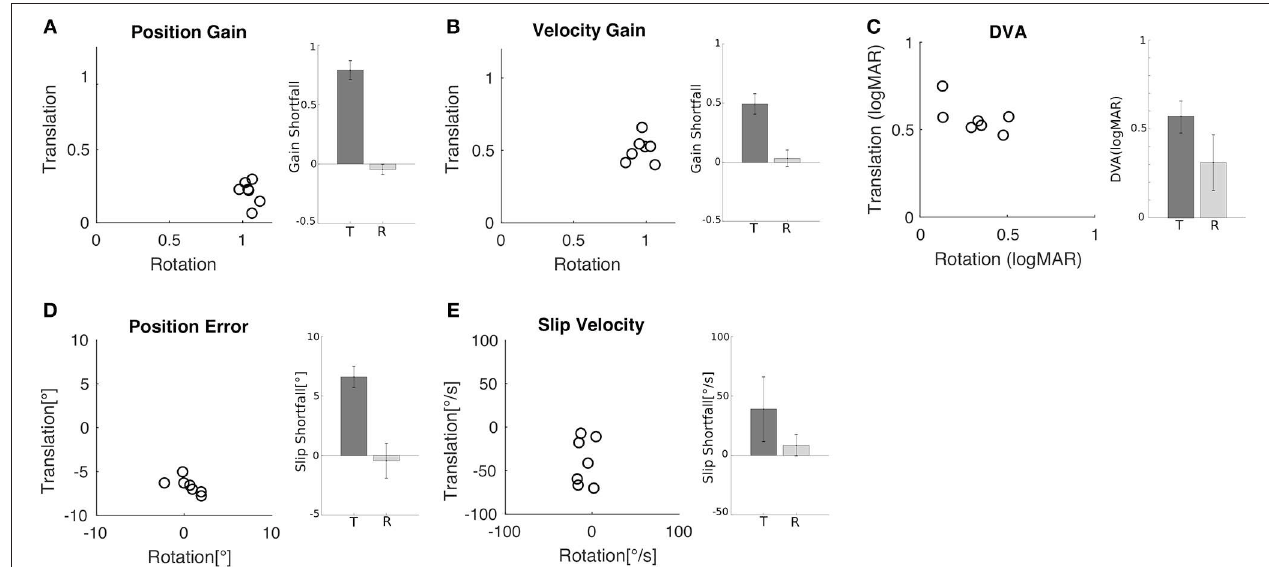
FIGURE 3 | Comparison of rotational and translational VOR gain, slip, and DVA. (A) Position error for translation vs. rotation for all subjects. Inset shows the mean ( ± SD) shortfall in gain relative to gain of one across subjects for translation (0.79 ± 0.08) and rotation ( − 0.05 ± 0.04). (B) Velocity gain for translation vs. rotation for all subjects. Inset shows the mean ( ± SD) shortfall across subjects for translation (0.49 ± 0.09) and rotation (0.07 ± 0.03). (C) DVA for translation vs. rotation for all subjects; larger values indicate worse acuity. Inset shows the mean ( ± SD) across subjects for translation (0.56 ± 0.09 logMAR) and rotation (0.32 ± 0.15 logMAR). (D) Retinal error during translation and rotation for all subjects. Negative values indicate under compensation. Inset shows the mean ( ± SD) shortfall relative to zero error across subjects for translation (6.61 ◦ ± 0.89 ◦ ) and rotation ( − 0.44 ◦ ± 1.46 ◦ ). (E) Retinal slip velocity during translation and rotation for all subjects. Inset shows the mean ( ± SD) shortfall across subjects for translation (39 ± 27.2 ◦ /s) and rotation (8.57 ± 9.05 ◦ /s).